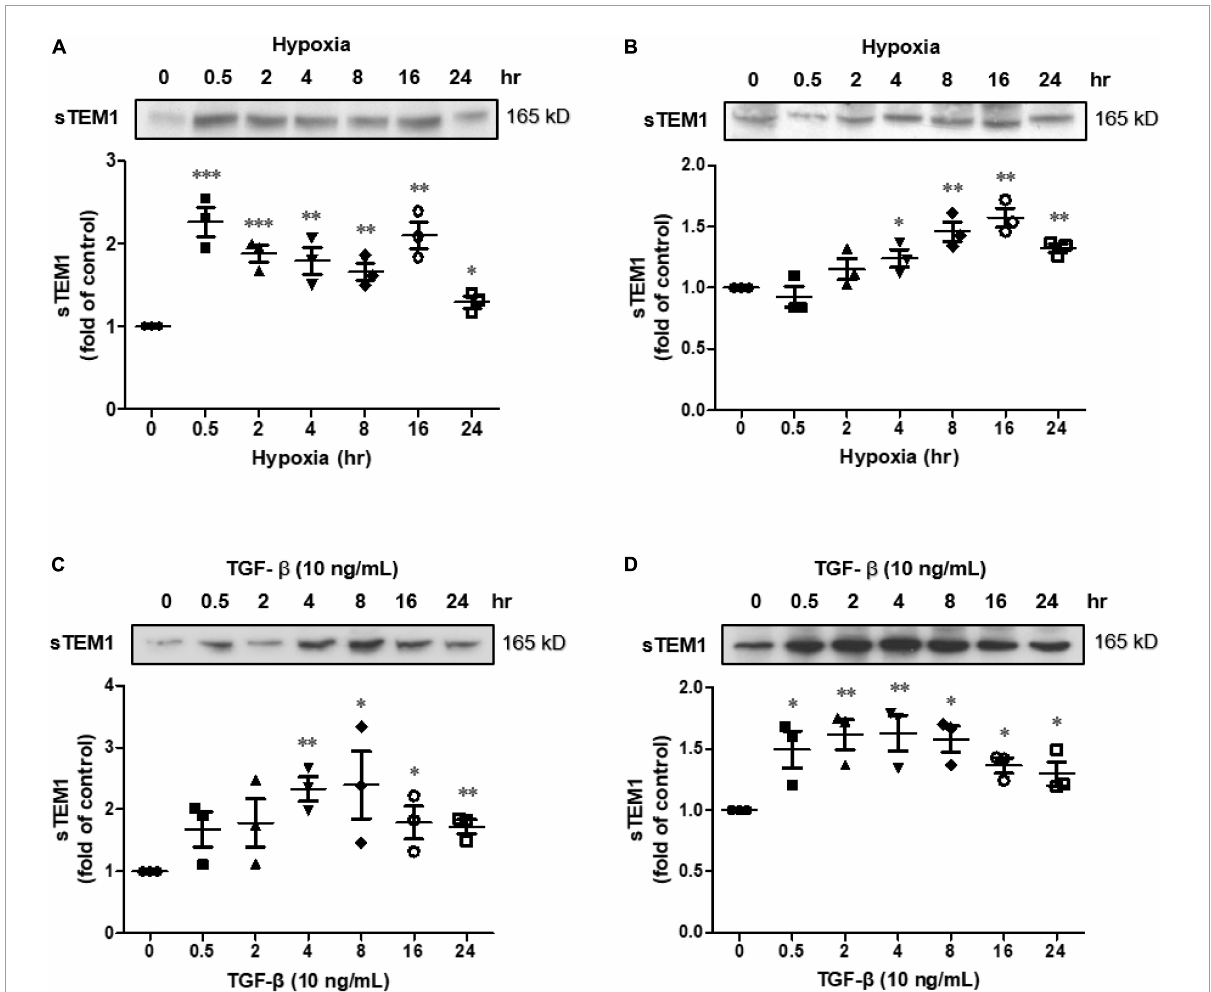
FIGURE3 Soluble TEM1 in the cultured media. Soluble TEM1 in the conditioned media of cultured H9c2 cells (A) and cardiac fibroblasts (B) exposed to hypoxia incubator prefilled with 1% oxygen for 24 h. Soluble TEM1 in the conditioned media of cultured H9c2 cells (C) and cardiac fibroblasts (D) treated with pro-fibrotic mediator, TGF- β . The expression levels were analyzed by western blot and expressed as a ratio to baseline without hypoxia or TGF- β n = 3. ∗ p < 0.05, ∗∗ p < 0.01 and ∗∗∗ p < 0.001 compared to normal at time